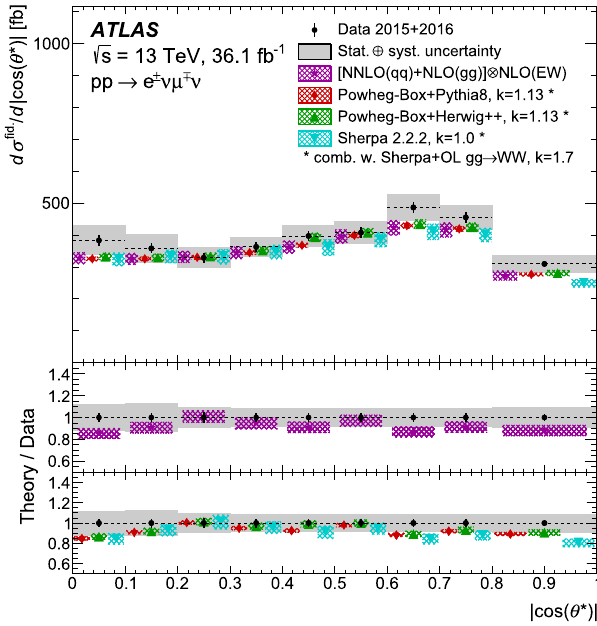
Fig. 8 Measured fiducial cross-sections of WW → e μ production for two of the six observables: (cid:6)φ e μ and | cos θ ∗ | . The measured cross- section values are shown as points with error bars giving the statistical uncertainty and solid bands indicating the size of the total uncertainty. The results are compared with the NNLO prediction with extra NLO EW corrections and NLO corrections for gg → WW production, and with NLO+PS predictions from Powheg- Box + Pythia 8, Powheg-